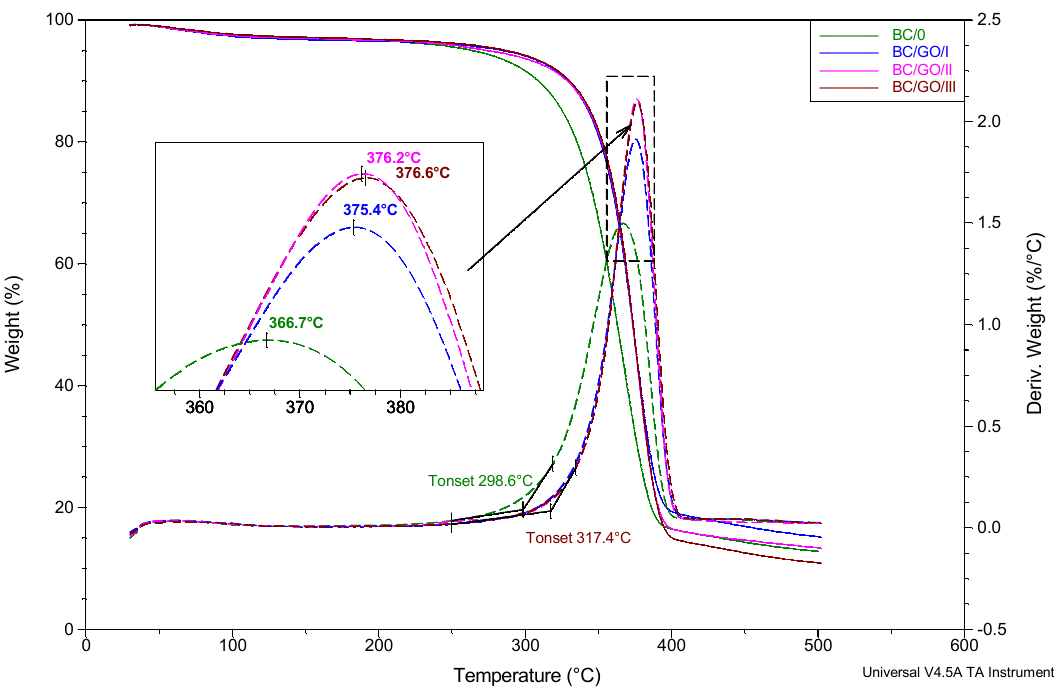
Figure 11. Summary of TG and dTG curves for membrane BC/0, BC/GO/I, BC/GO/II, BC/GO/III samples. Heating rate 20°/min. N 2 atmosphere flow 60 mL/min.